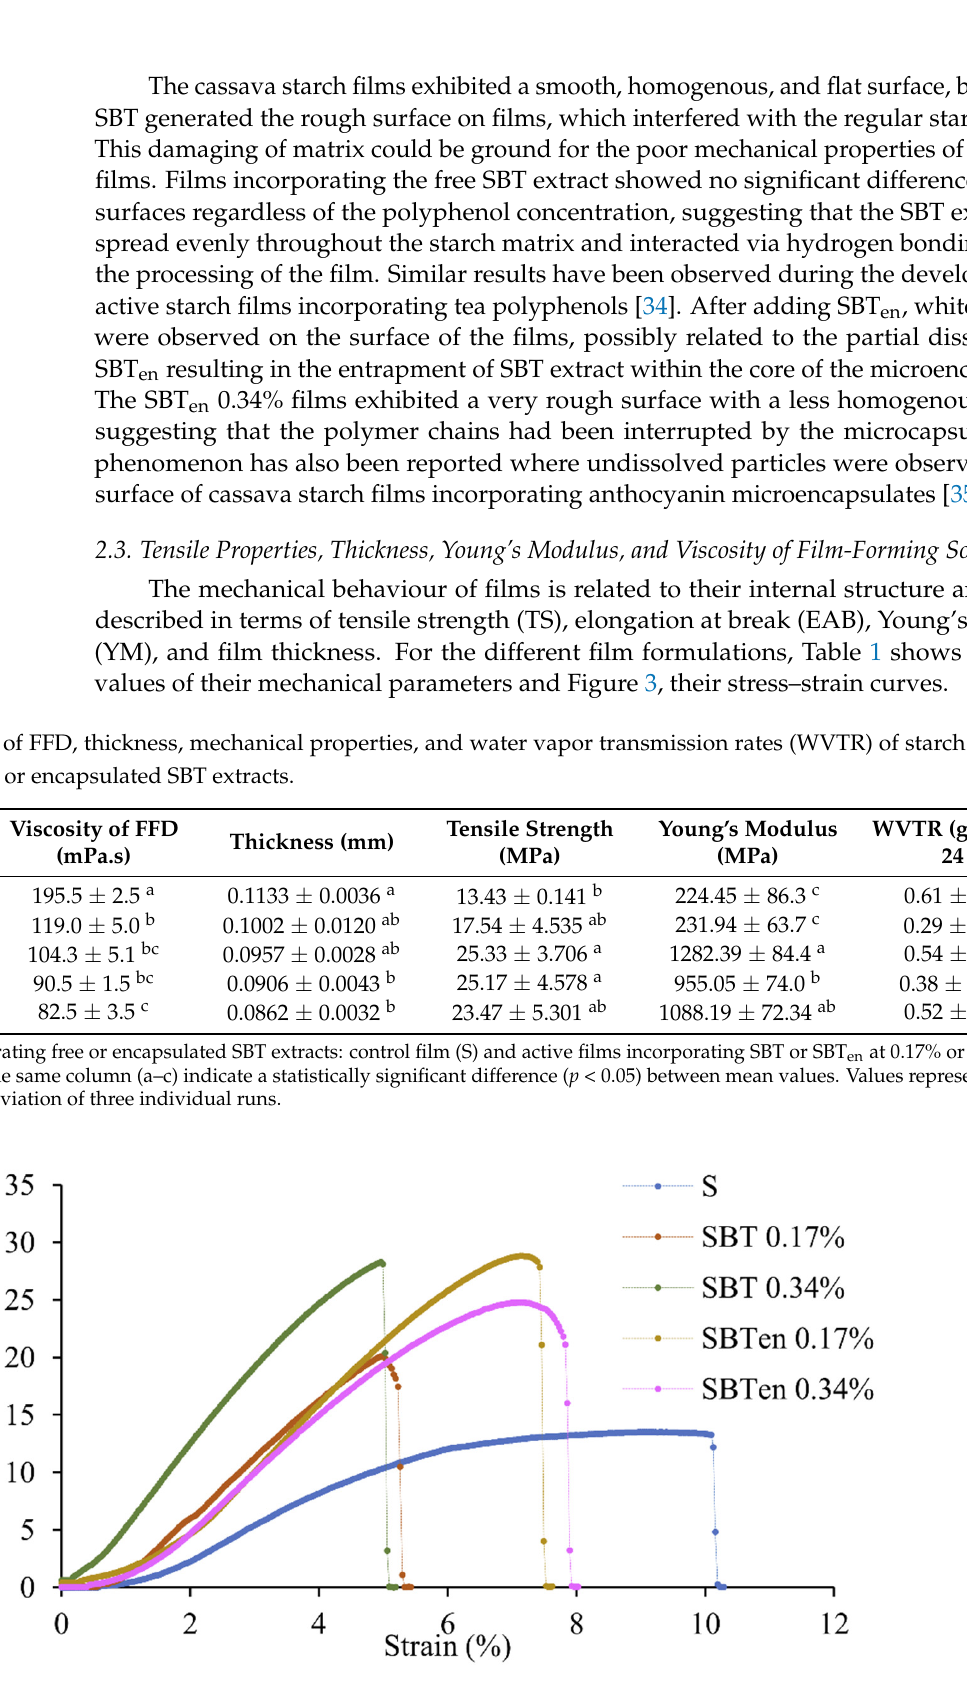
Figure 3. Stress–strain curves of starch films incorporating free or encapsulated SBT extracts: control film (S) and active films incorporating SBT or SBT en at 0.17% or 0.34%.